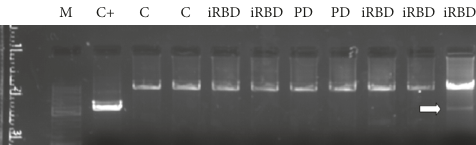
Figure 3: MtDNA deletions . 0.8%-agarose gel containing amplified mtDNA. White arrow shows a iRBD patient presenting a unique mtDNA deletion. C, controls; iRBD, idiopathic REM behavior disorder patients; PD, Parkinson’s disease patients; C+, internal reference positive control; mtDNA, mitochondrial